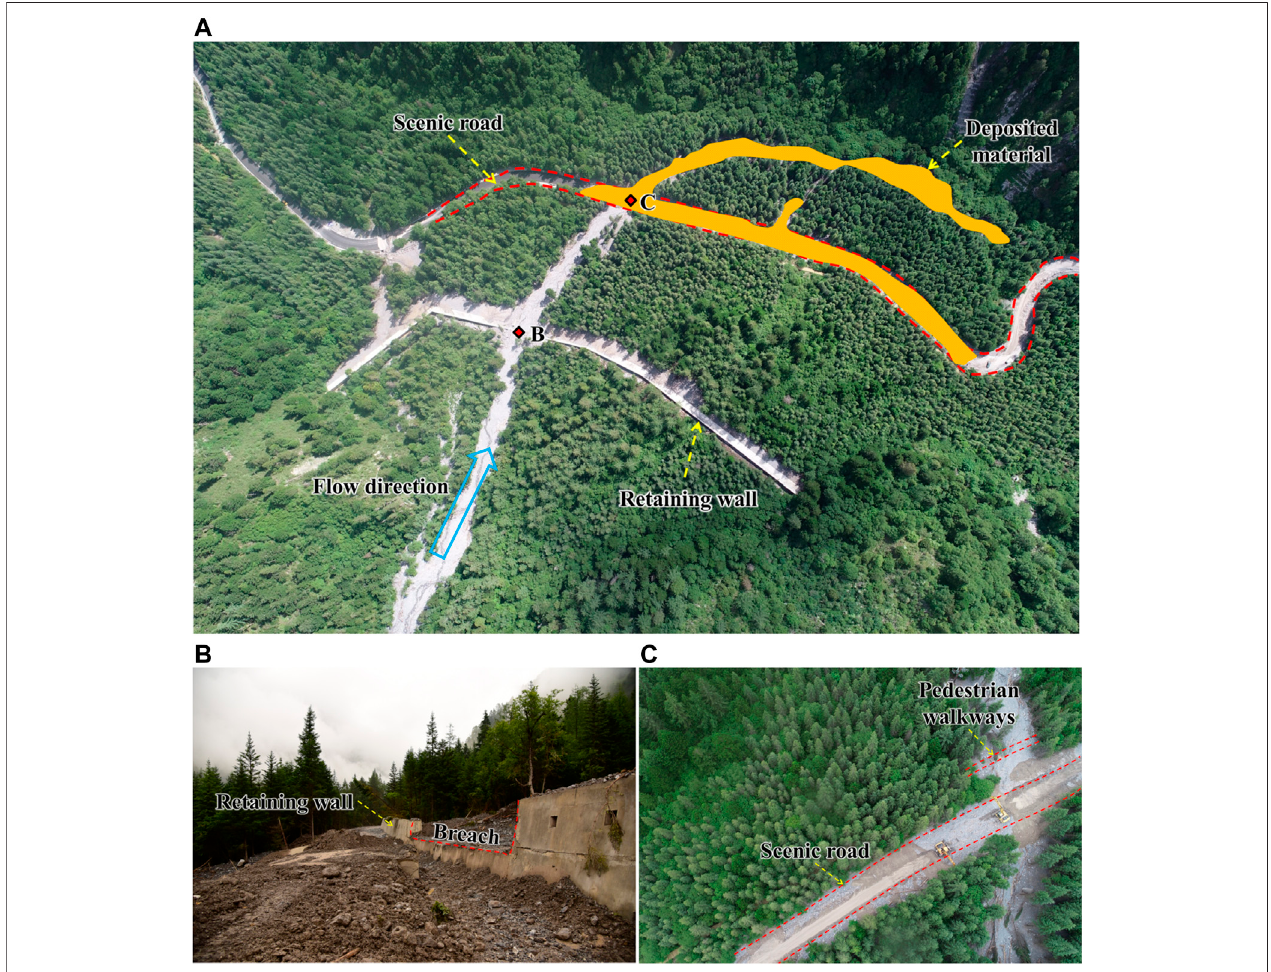
FIGURE 5 | Mitigation measures in Zhuozhui Gully. (A) Overview of the mitigation structures; (B) The damaged retaining wall, corresponding to point B in (A) . (C) The debris fl ow material deposited on the scenic road, corresponding to point C in (A) .